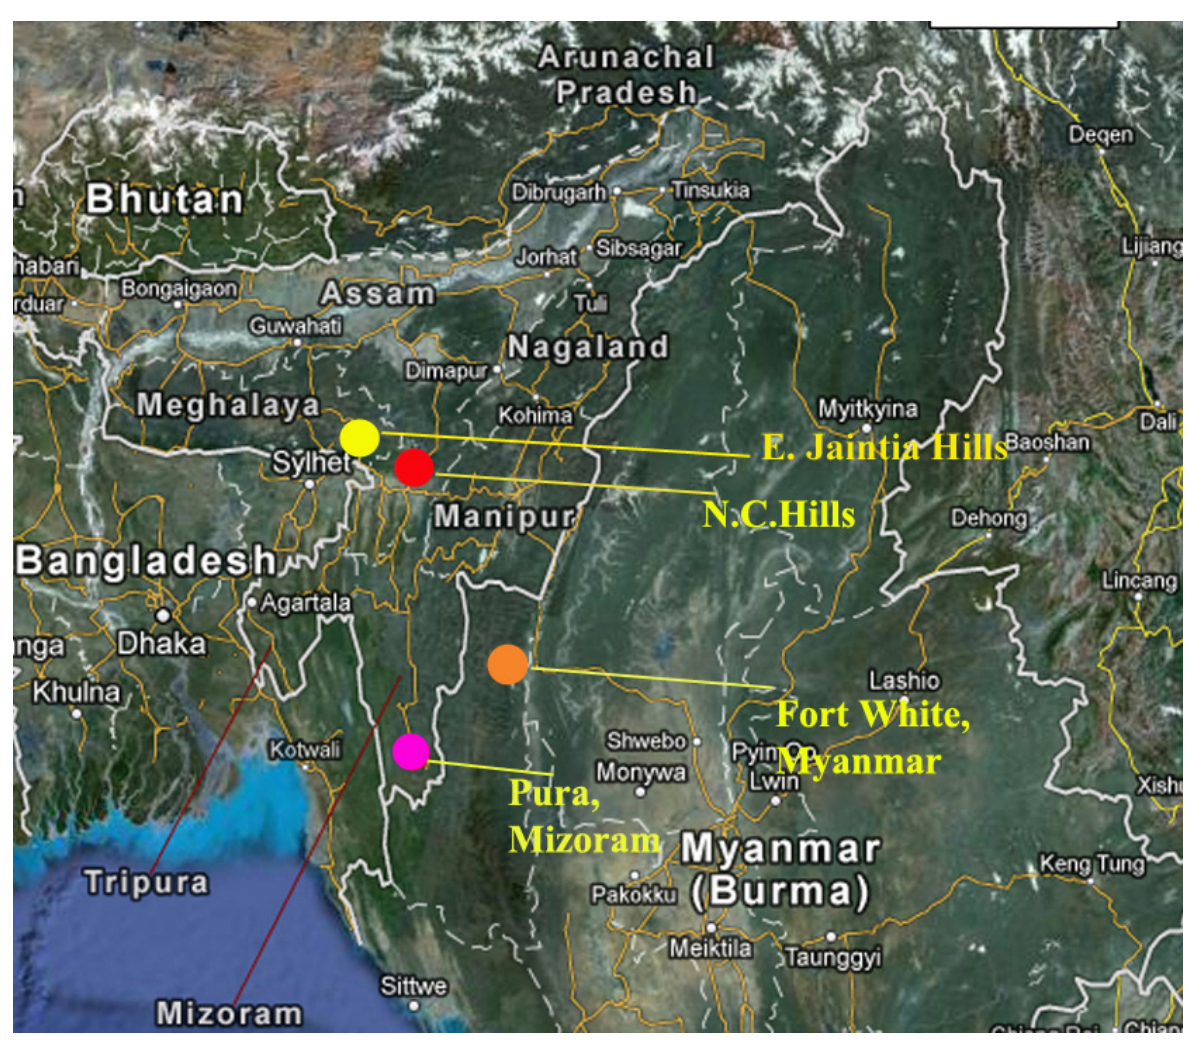
Image 1. Map showing the sighting of Athyma whitei from Chin-type locality (orange dot) Myanmar; Pura, Mizoram-past record (pink dot) and E. jaintia (yellow dot) Cachar, Assam-new record (red dot).